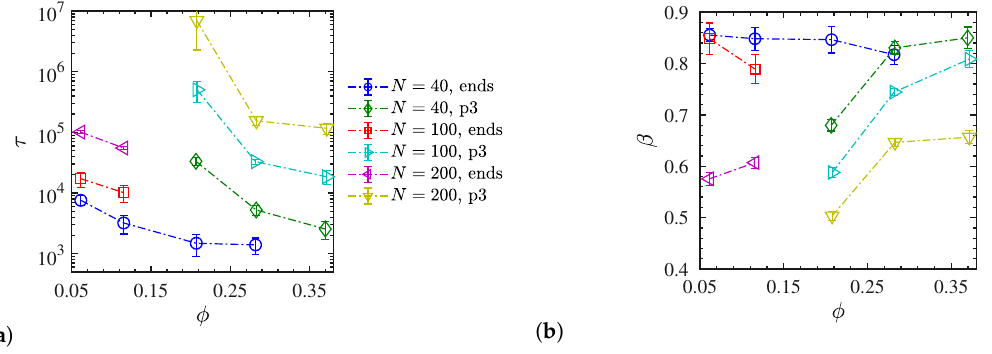
Figure 7. ( a ) Average chain end–end relaxation time τ and ( b ) the corresponding stretched exponent β for liquid-like dispersed systems. Dash-dotted lines are guides to the